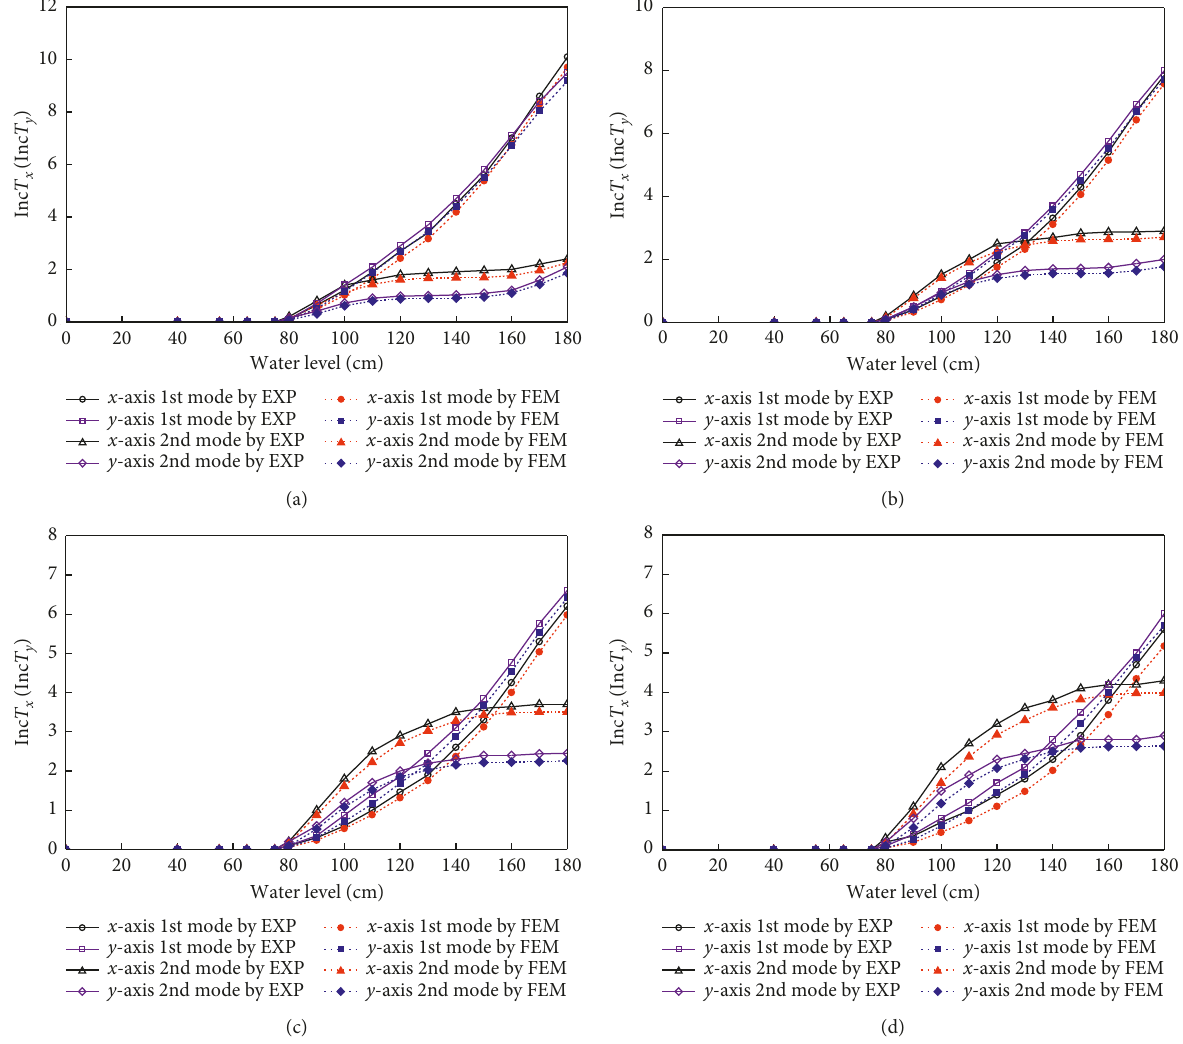
Figure 7: Measured and computed percentage increases of vibration period for the hollow pier specimen in case II as a function of water level: (a) without tip mass; (b) with an 11.4kg tip mass; (c) with a 23.4kg tip mass; and (d) with a 31.7kg tip